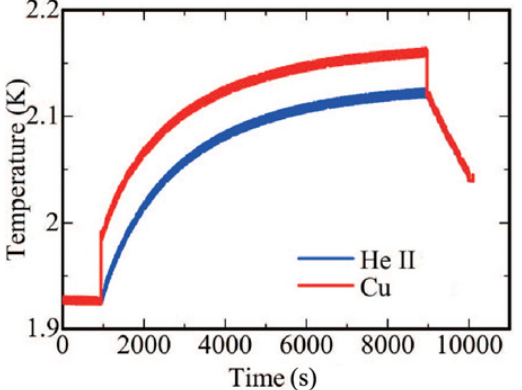
Figure 6. Result of Kapitza conductance measurement in the temperature range 1.93 K to 2.15 K.